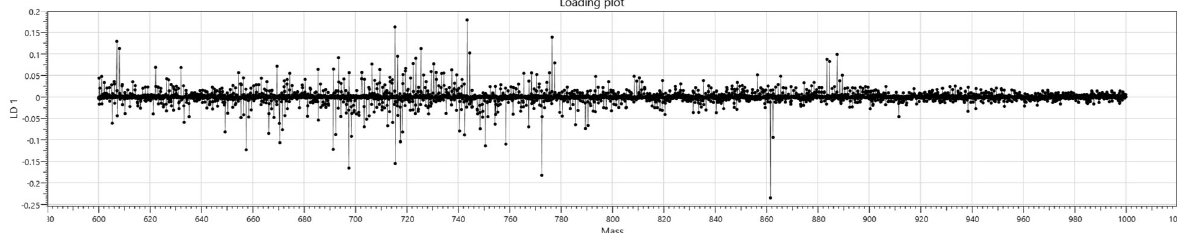
Fig. 5 Production system loading plot. Loading plot showing discreet differences in lipids for Linear Discriminant 1 in the production system model.